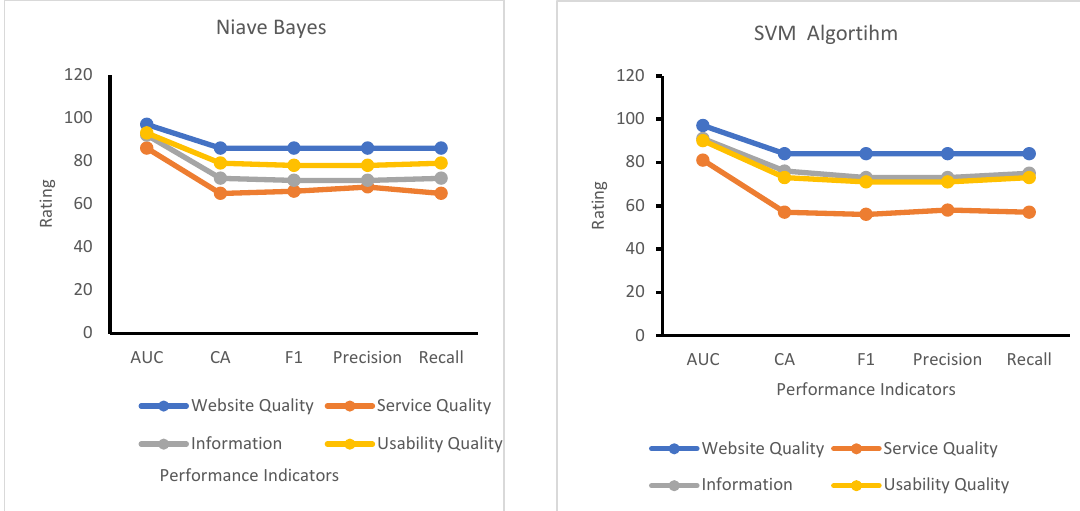
Fig. 24. Results for Naive Bayes algorithm Fig. 25. Results for SVM algorithm